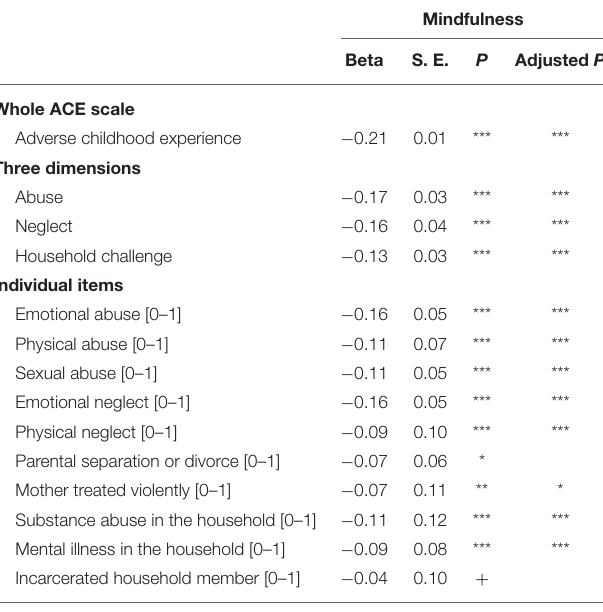
TABLE 4 | Robustness tests of ACE subscales and items on